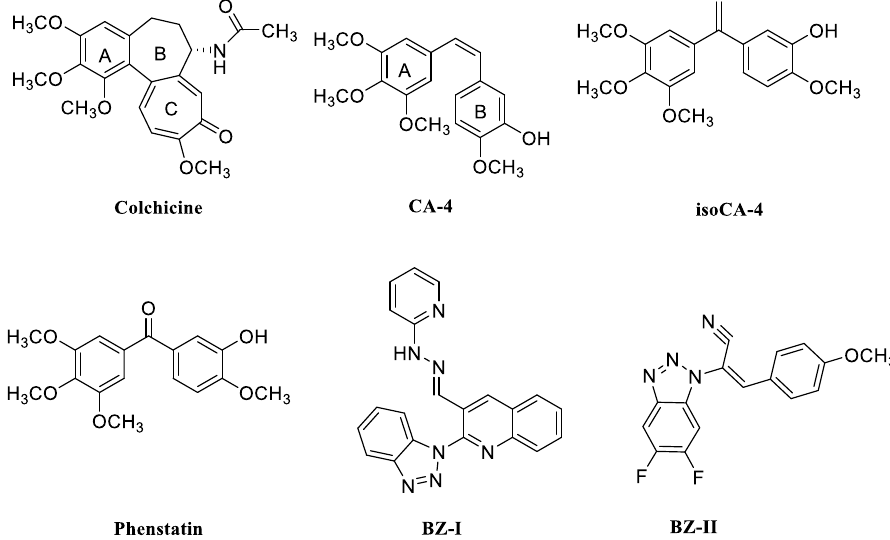
Figure 1. Chemical structure of Colchicine, CA-4 and its analogues and tubulin targeting agents bearing benzotriazole moiety (BZI & BZII).